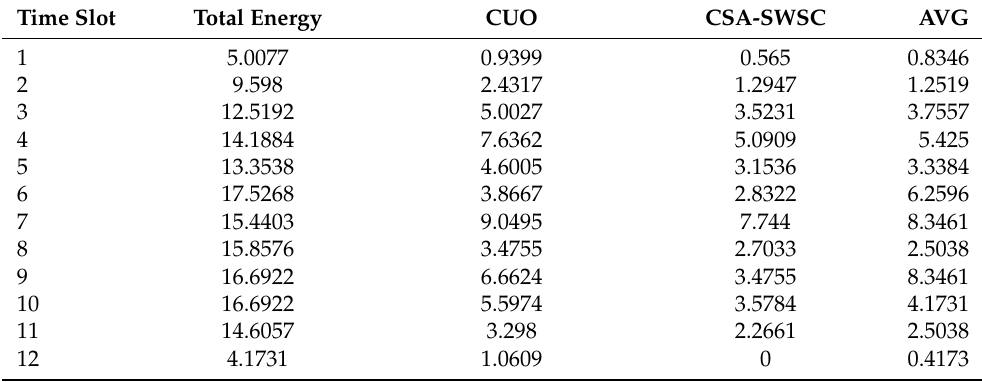
Table 1. Total Carbon emission (kg CO 2